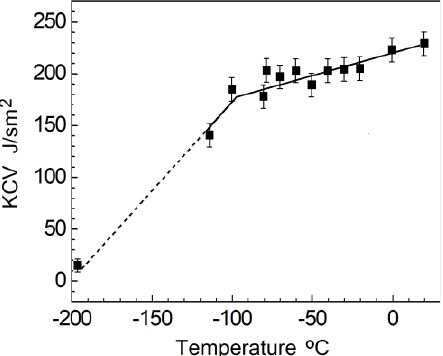
Figure 7. The scheme for external load work at all deformation and fracture stages during the impact bending tests ( a ), where A I is the work associated with the elastic strains, A II – with the plastic stains and the main crack appearance, and A III – with the main crack propagation; A II and A III temperature dependences ( b ).